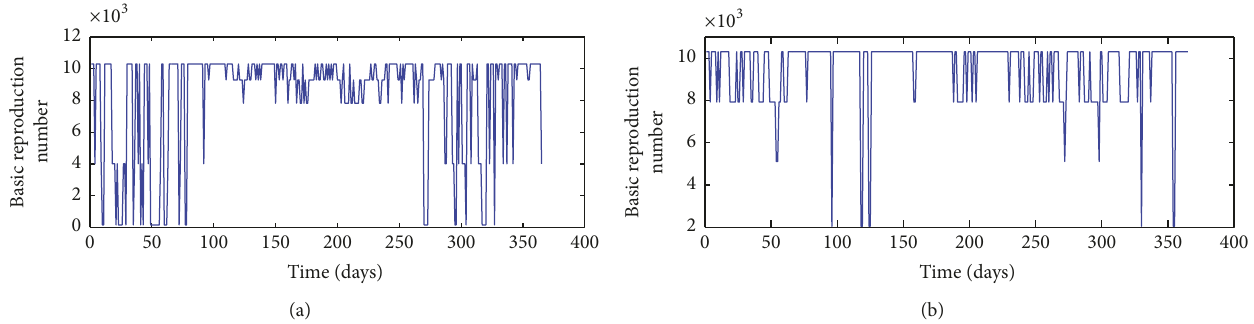
Figure 18: Distribution of 𝑅 0 based on fluctuation of temperature (a) and relative humidity (b) data in